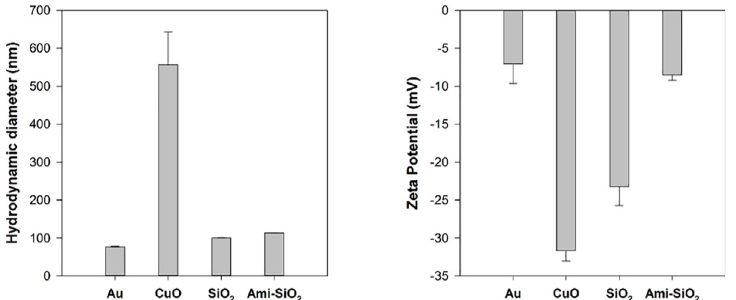
Fig 2. Hydrodynamic diameter of Au, CuO, SiO 2 , and Ami-SiO 2 evaluated in ultrapure water and zeta potential evaluated in 0.5x PBS.